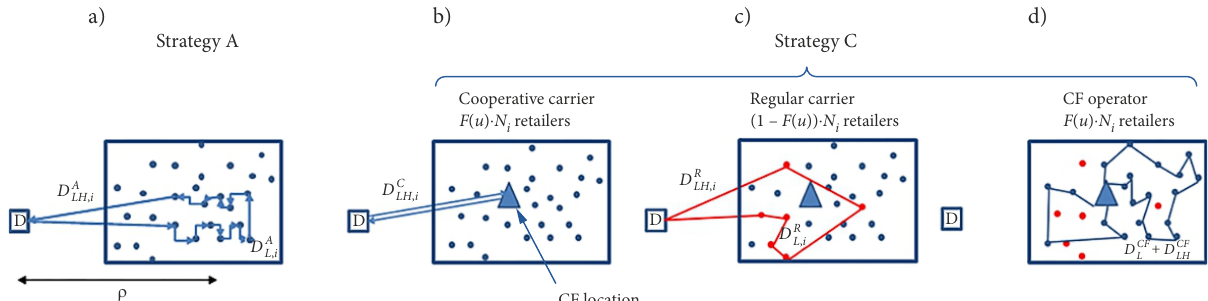
Figure 2. Comparison of distribution phases in Strategy A (a) and Strategy C (b – cooperative carrier, c – regular carrier, d – CF operator)